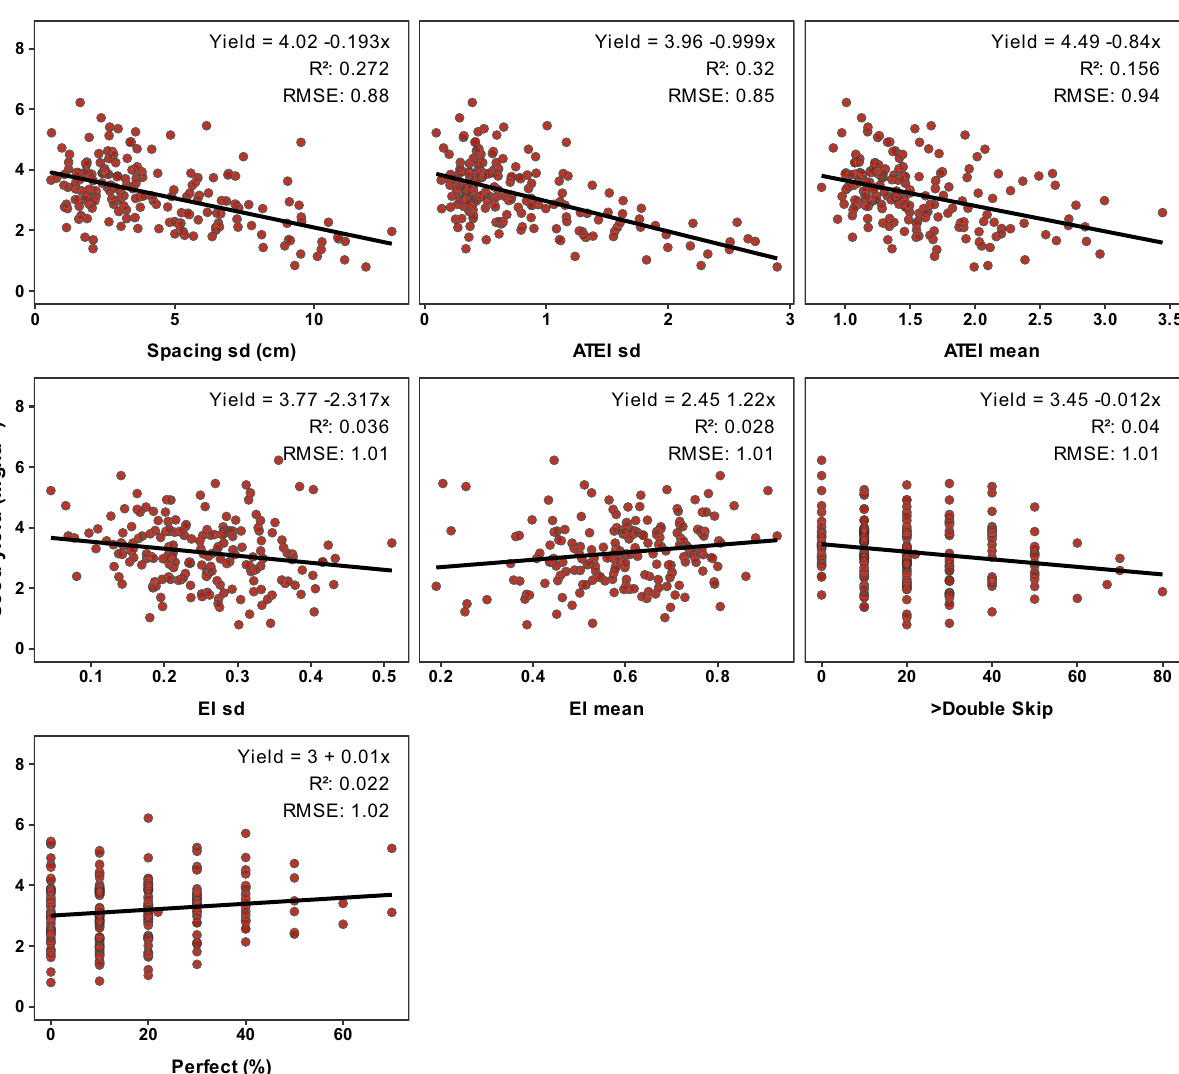
Figure 2. Relationship between stand uniformity variables and soybean yield for US studies. ATEI mean and sd achieved versus targeted evenness index mean and standard deviation, EI mean and sd evenness index mean and standard deviation, Perfect percentage of perfectly spaced plants, R 2 coefficient of determination, RMSE root mean square error. All stand uniformity variables presented a significant slope at alpha =